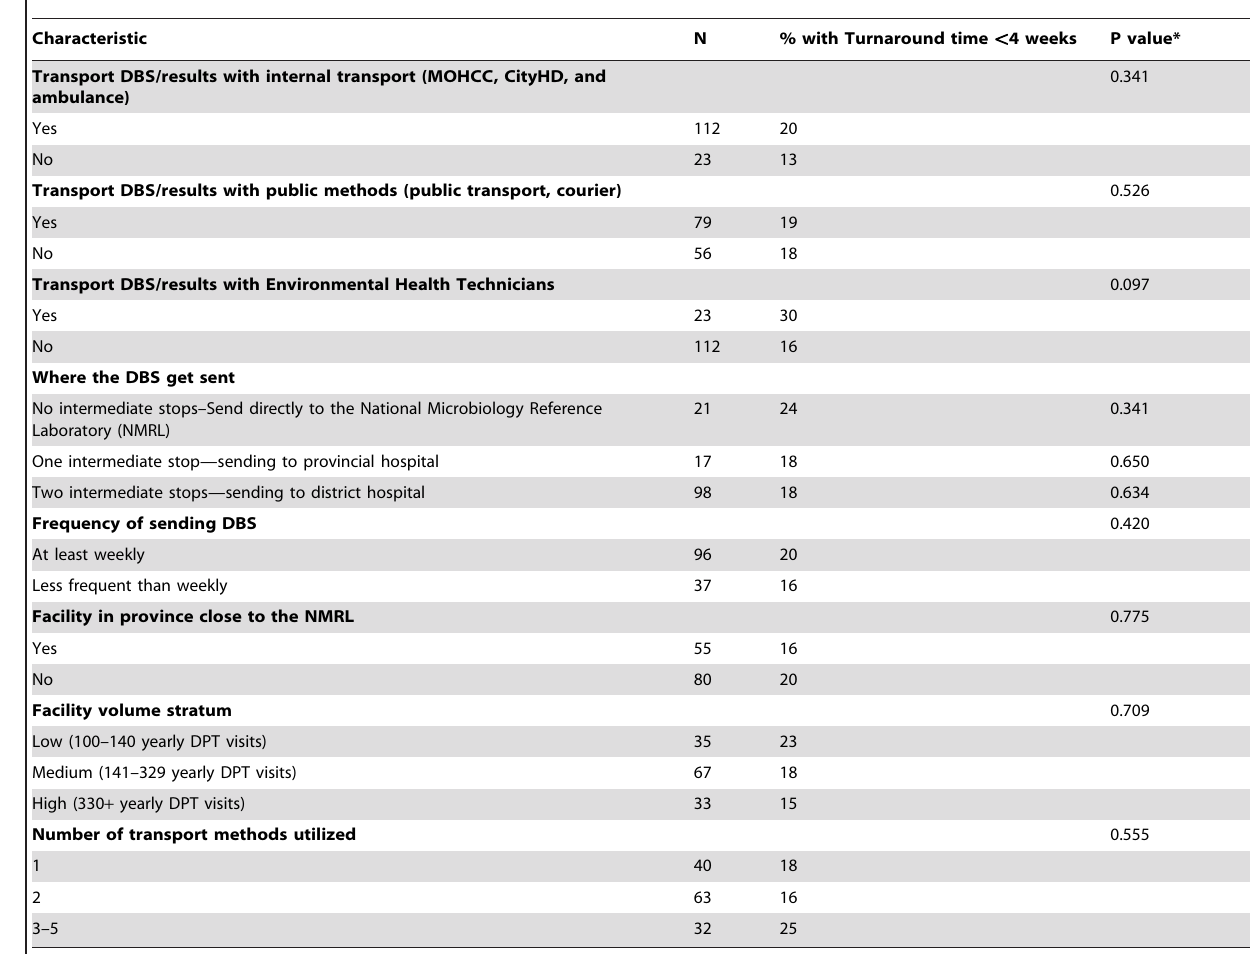
Table 3. Bivariable analysis: Factors associated to turnaround time for DBS HIV DNA PCR testing.